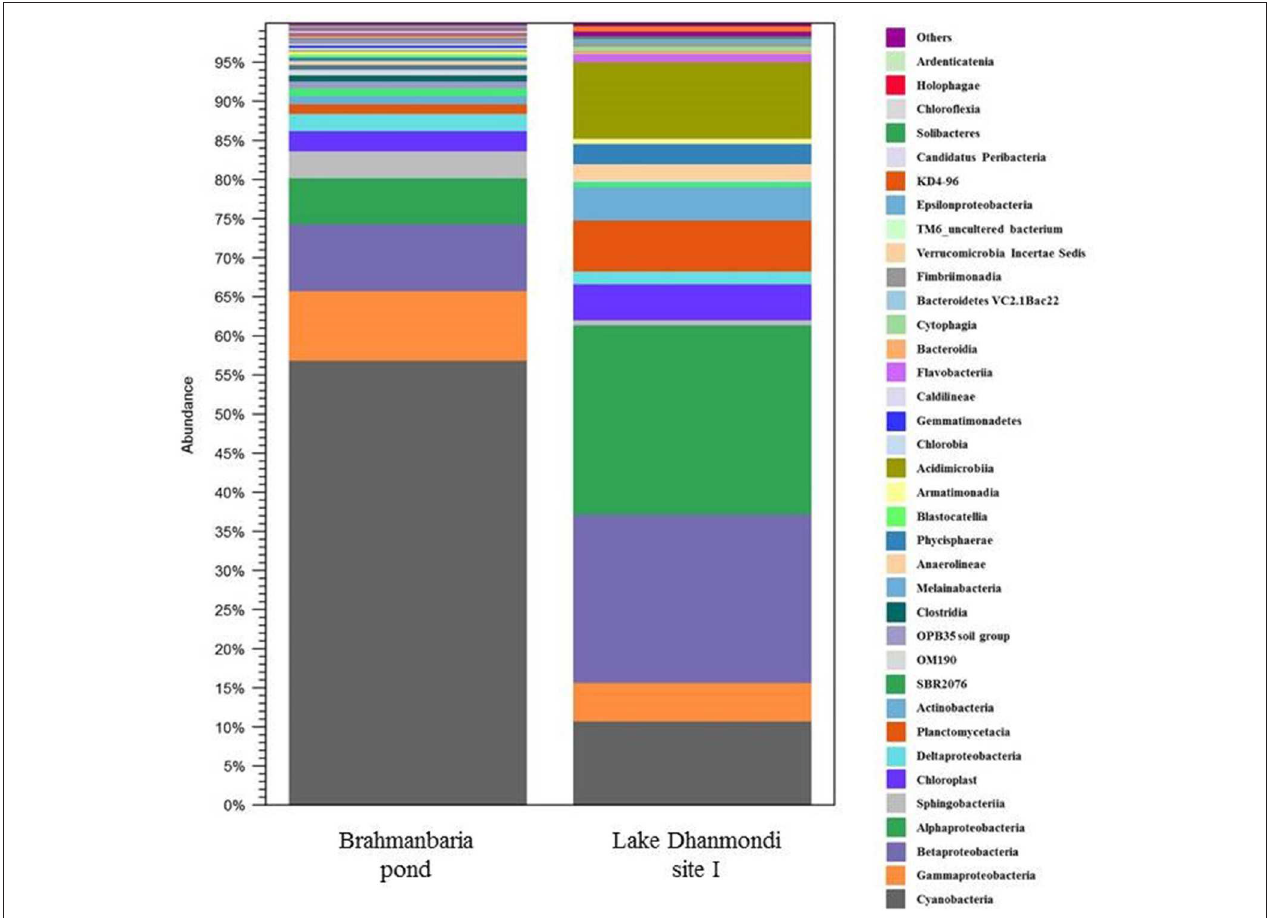
FIGURE 7 | Distribution of bacterial classes in Brahmanbaria pond and Lake Dhanmondi Site I, based on deep 16S rDNA